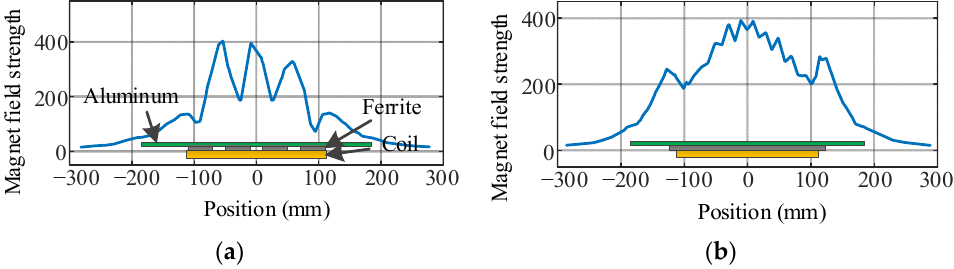
Figure 2. Magnet field strength curves for different directions of the inner soft magnetic strips. ( a ) x ‐ axis. ( b ) y ‐ axis. Table 1. Basic parameters of the adopted materials.